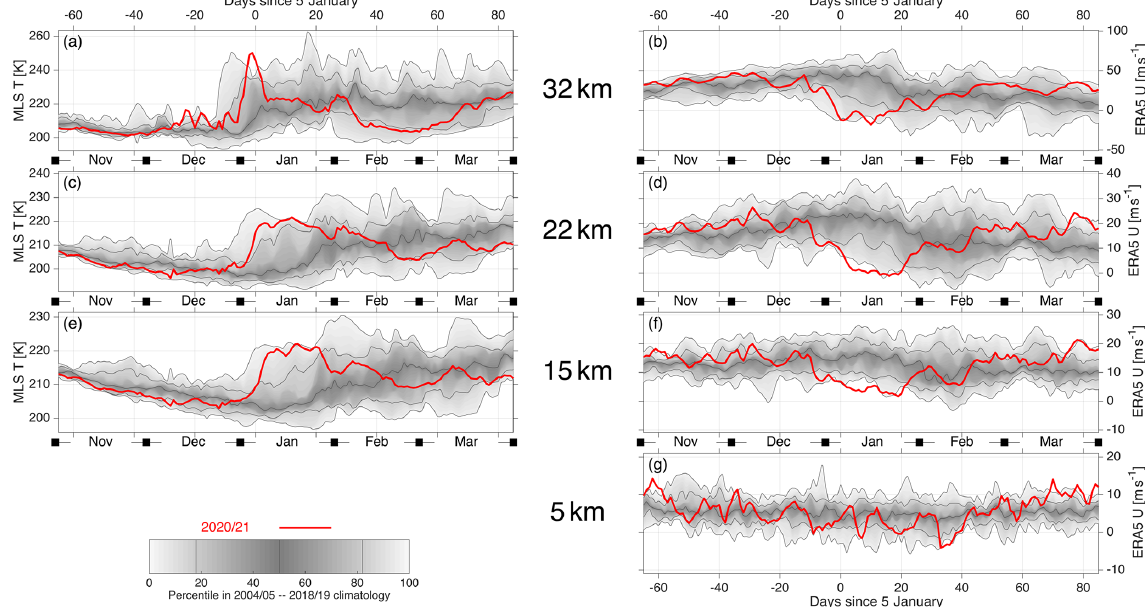
Figure 3. Context of the January 2021 SSW in relation to a 2004/05–2019/20 climatology of zonal mean (a, c, e) MLS temperatures and (b, d, f, g) ERA5 zonal winds at (a, b) 32km, (c, d) 22km, (e, f) 15km and (g) 5km altitude. Grey shading shows the climatological distribution, with the 0th, 18th, 50th, 82nd and 100th percentiles (i.e. non-parametric equivalents of the range, median, and first and second standard deviations) emphasised by solid grey lines. Red line shows winter 2020/21 within this